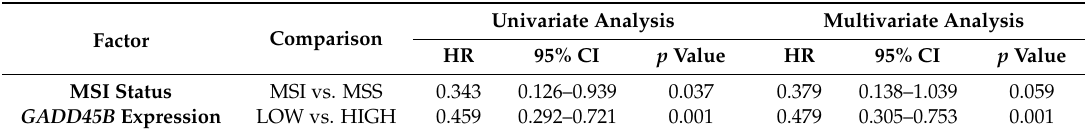
Table 3. Cox analyses of potential prognostic factors for overall survival in the stage II CRC cohort. Factor